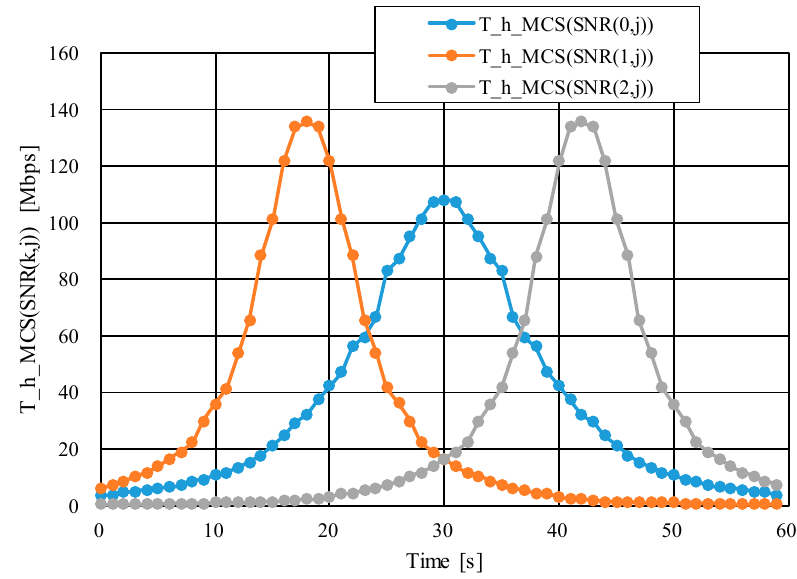
Figure 11. T h_MCS throughput of each base Figure 11. 𝑇 (cid:2918)_(cid:2897)(cid:2887)(cid:2903) throughput of each base station.